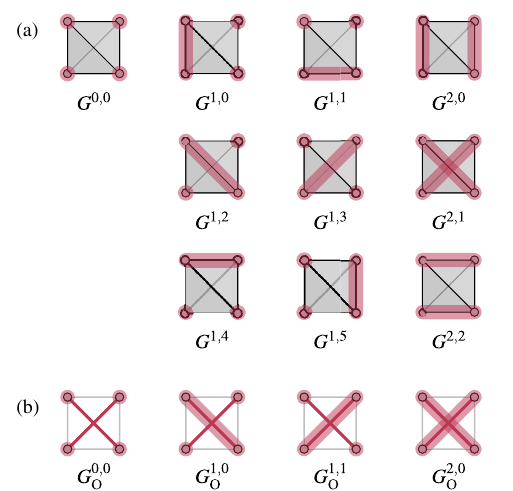
FIG. 11. Tetrahedron graphs for the (a) bulk and (b) orphan tetrahedra for [001] spin-ice films, as used in Eq.